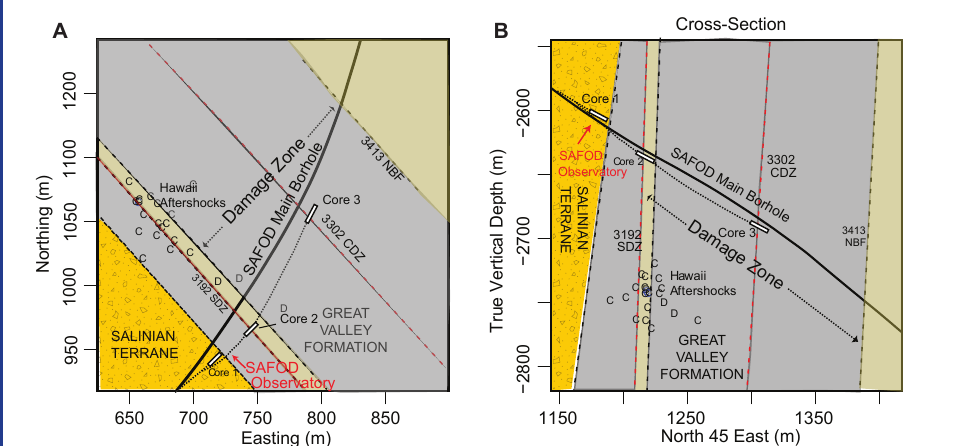
Figure 5. [A] Map view and [B] cross-section of the trajectory of the rotary-drilled SAFOD main borehole as it passed through the San Andreas Fault Zone at a depth of ~2700 m, as well as the trajectories of the sidetrack boreholes used to obtain core samples along the actively deforming traces of the fault during Phase 3. Note the positions of the SDZ, CDZ, and NBF and the extent of the damage zone as defined in Figs. 2, 3, and 4. Also shown are single-station locations of the aftershocks of the 11 August 2006 Hawaii target earthquake recurrence; these were made using a seismometer in the main hole at a true vertical depth of 2660 m. The “C” and “D” symbols refer to the polarity of the P-wave from each aftershock. Because the borehole seismometer is offset to the northeast from the fault trace, the transition from “C” to “D” occurs where expected for right lateral slip on the